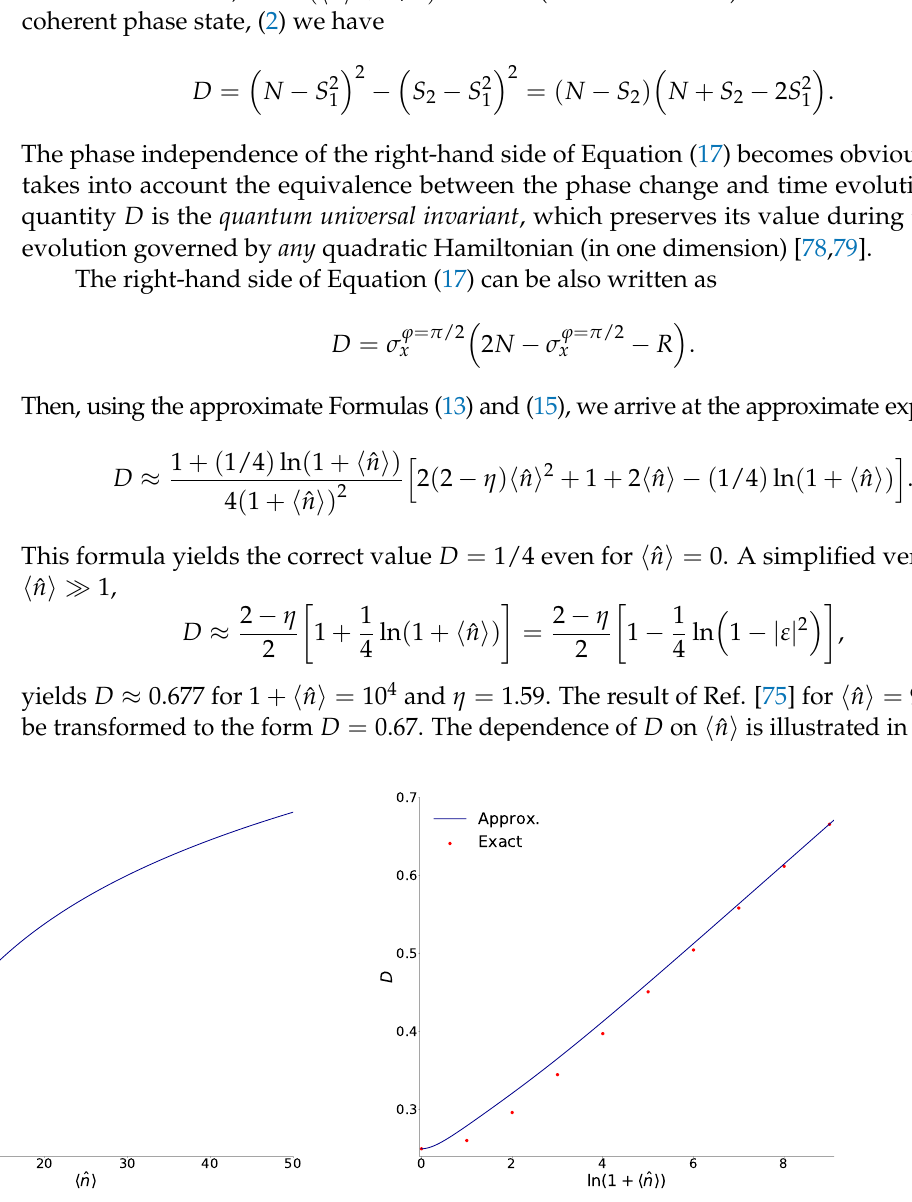
Figure 3. The Robertson–Schrödinger uncertainty product D versus the mean number of quanta (cid:104) ˆ n (cid:105) in the coherent phase state (2). Left: D as function of (cid:104) ˆ n (cid:105) for relatively small values of (cid:104) ˆ n (cid:105) (numeric results). Right: the comparison of the approximate analytical formula (19) with exact numerical values. The best coincidence happens for η = 1.59. The series S 1 and S 2 were calculated numerically, taking into account up to 640,000 terms for high values of (cid:104) ˆ n (cid:105) , in order to obtain a good